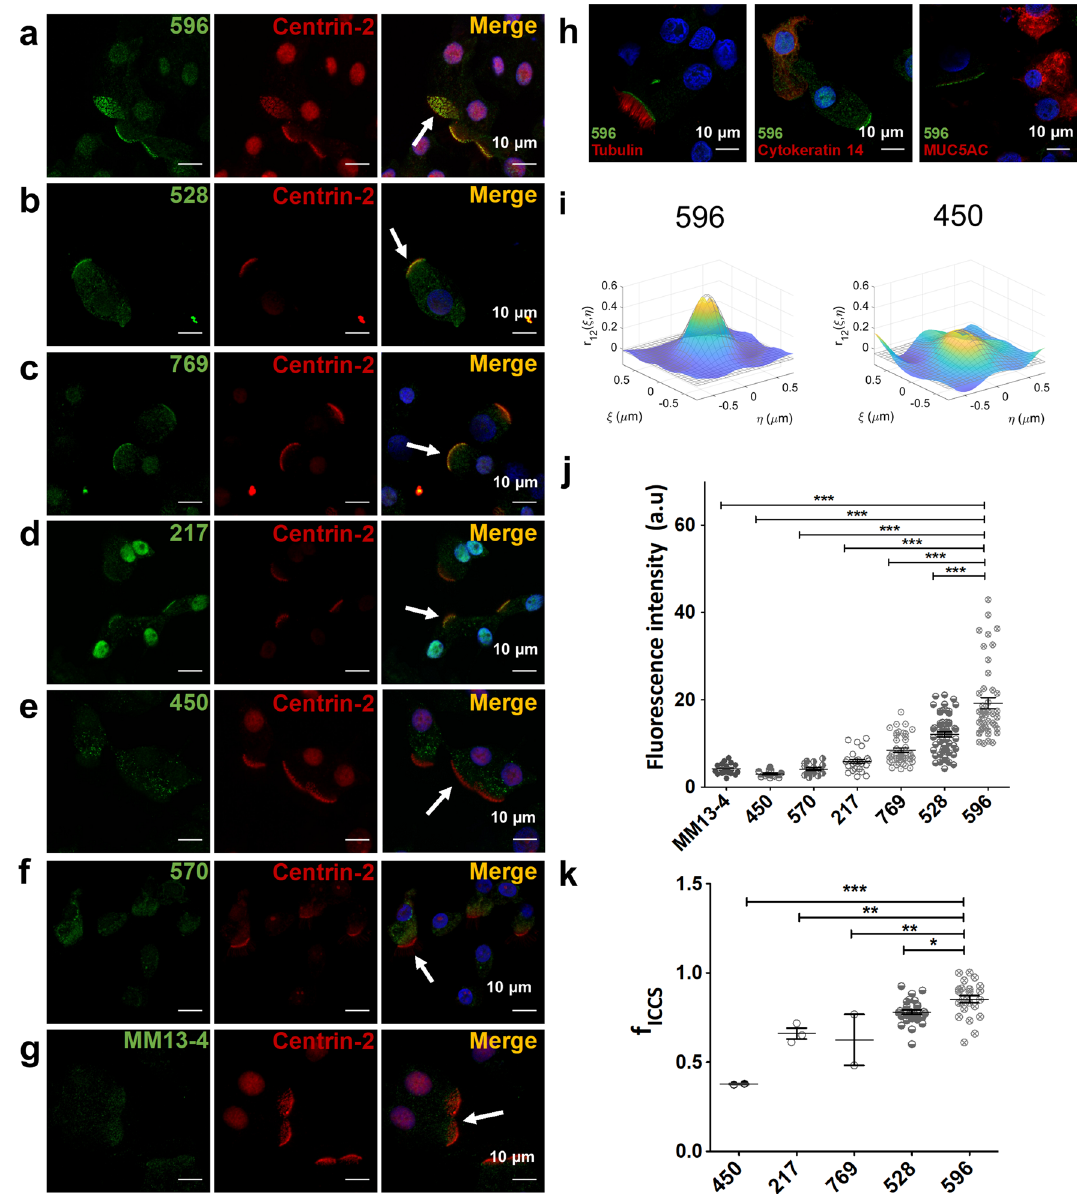
Figure 2. The bases of cilia are immunostained using CFTR antibodies 596, 528, 769 and 217, but not 450, 570 and MM13-4. ( a–g ) Confocal images of well differentiated HBEs co-immunostained with CFTR antibodies 596, 528, 769, 217, 450, 570 or MM13-4 and the ciliated cell marker centrin-2 . Arrows indicate ciliated cells. ( h ) Confocal images of cells coimmunostained with 596 and antibodies against either tubulin (left, ciliated cell marker), cytokeratin 14 (middle, basal cell marker) or MUC5AC (right, goblet cell marker). ( i ) Representative spatial cross-correlation functions calculated via ICCS analysis between centrin-2 and CFTR immunofluorescence using 596 (left) or 450 (right) measured from image sub-regions of interest (64 × 64 pixels). ( j ) Average apical immunofluorescence signals with different CFTR antibodies. Intensities were normalized to the excitation power (mean ± SD, n = 12–57, *** p < 0.0001, one-way ANOVA). ( k ) Colocalized fraction f ICCS extracted from ICCS analysis (mean ± SD, n = 2–28, 450 vs 596, *** p < 0.0001; 217 vs 596, ** p = 0.005; 769 vs 596, ** p = 0.0059; 528 vs 596, * p = 0.0313), which indicates the arithmetic mean of the fractions of CFTR and centrin-2 antibody signals that Antibodies 596, 528, 769 and 217 immunostain the bases of motile cilia. We then examined ciliated cells, which were identified by co-immunostaining the ciliary marker proteins centrin-2 (basal body) or acetylated tubulin (axoneme). Antibodies 596, 528, 769 and 217 yielded robust fluorescence signals at the apical pole of ciliated cells as indicated by the white arrows in the merged images (Fig. 2a–d, j) consistent with previous reports 10,29,30 . The signals were strongest using 596, 528 and 769 and they were clearly situated at the bases of cilia (Fig. 2a–c). Similar results were obtained when 596 was used with HBE cultures from six non-CF